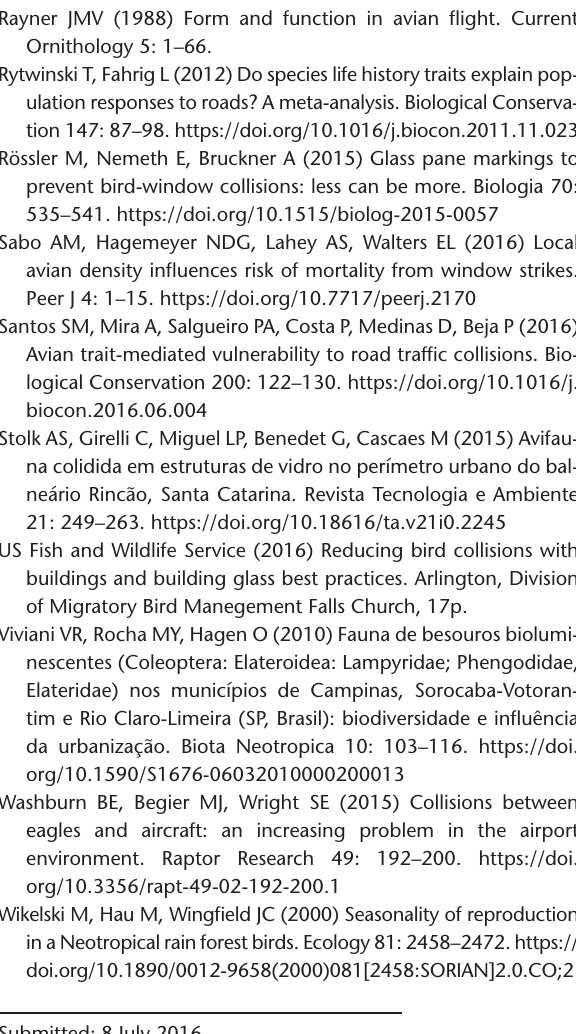
Figure S3. Bird-of-prey decals (20 cm × 40 cm) applied